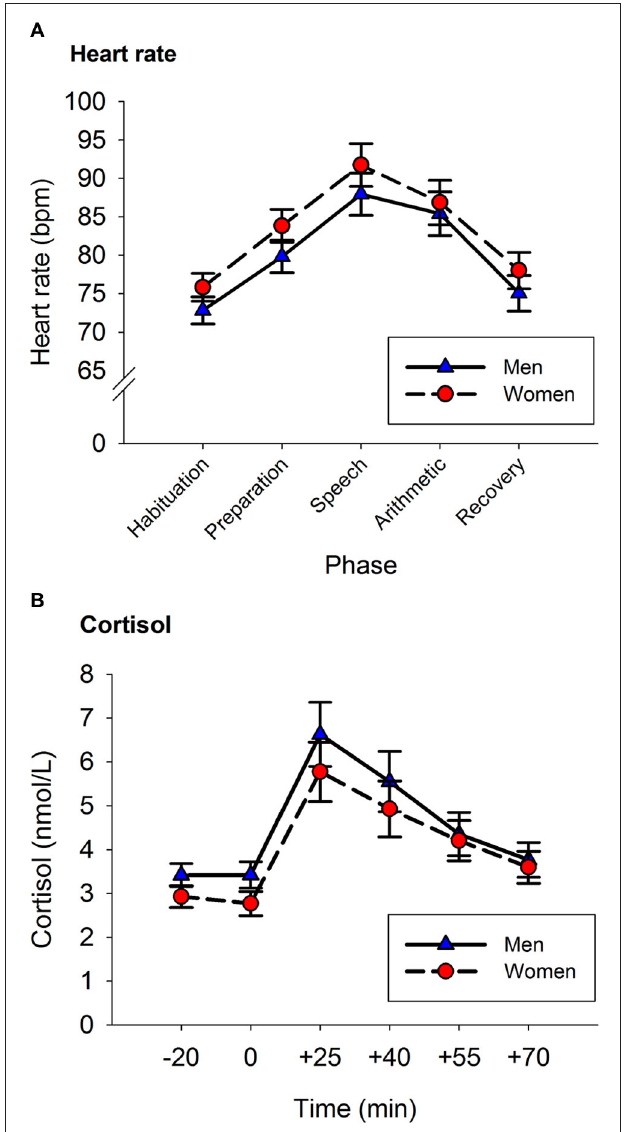
FIGURE 1 | Heart Rate (A) and Cortisol (B) responses to the TSST. Panel A : Heart rate increased from baseline until reaching peak levels during the speech phase. Afterwards, HR decreased reaching baseline levels in the recovery phase. Panel B : Cortisol levels increased from baseline until reaching peak levels at the +25 sample. Afterwards, cortisol levels decreased reaching baseline levels in the last saliva sample. Error bars represent